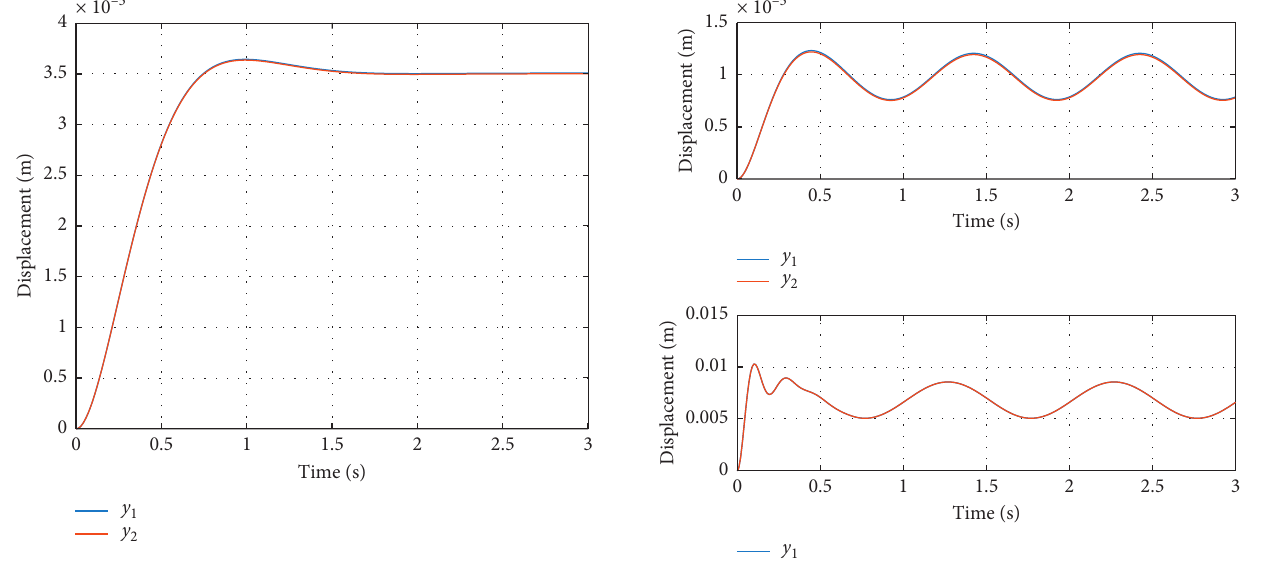
Figure 9: Experimental result based on the active control approach.